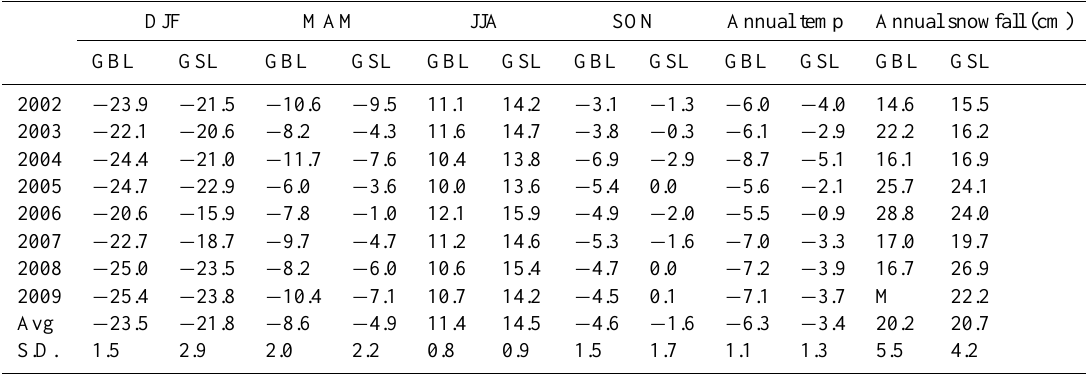
Table 2. Seasonal mean air temperature (6 ◦ C) for winter (DJF), spring (MAM), summer (JJA) and autumn (SON), and annual snowfall (cm) recorded at Deline (GBL), Yellowknife and Hay River combined (GSL) meteorological stations (2002–2009). M indicates missing data. S.D. is standard deviation.